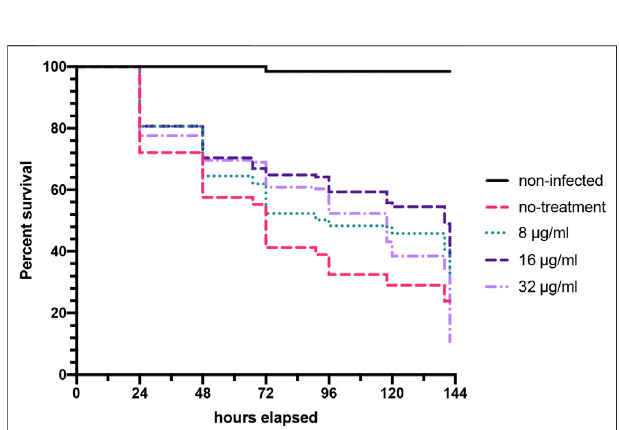
FIGURE 9 | Bay 11-7085 prolongs C. elegans survival after C. albicans infection. C. elegan wereexposed to C.albicans strain SC5314 grown on BHI agar plates, washed, and treated with various concentrations of Bay 11-7085 in liquid medium. Statistical signi fi cance was determined using Log-rank (Mantel-Cox). ( n (cid:2)